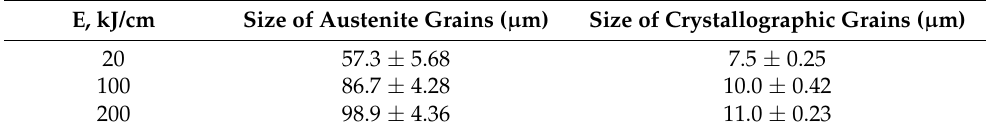
Figure 2. Optical images of the CGHAZ containing 0.14% Nb at varying heat inputs (kJ/cm). ( a ) 20, ( b ) 100, ( c ) 200. Table 3. Measurements of austenite grain size in